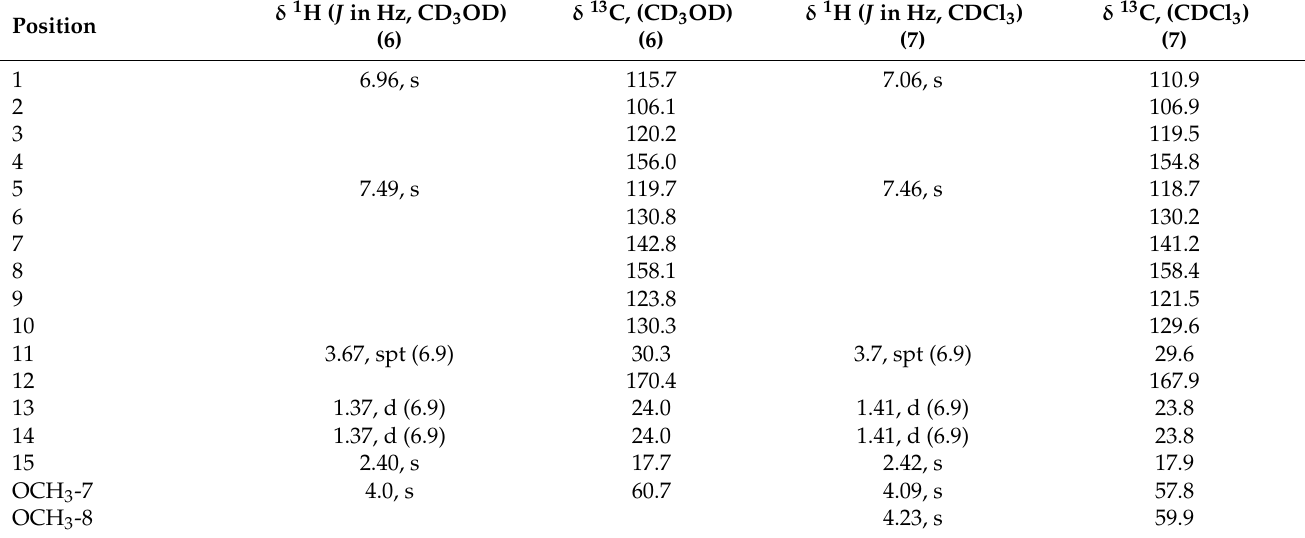
Table 2. 1 H and 13 C NMR spectroscopic data (600 MHz, δ ppm) for compounds 6 and 7